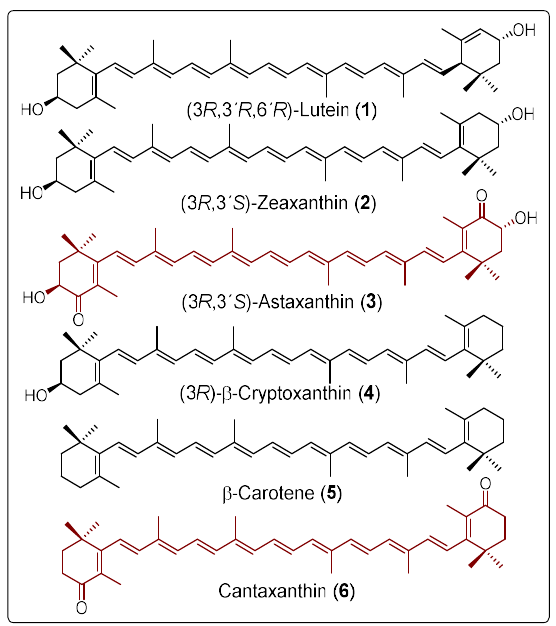
Figure 1. Structures of some common carotenoids.